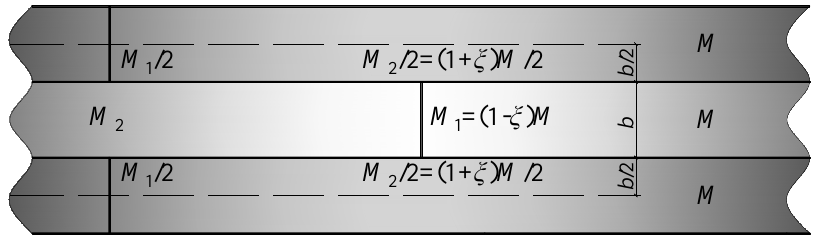
Figure 15. Illustration of bending moment transmission.